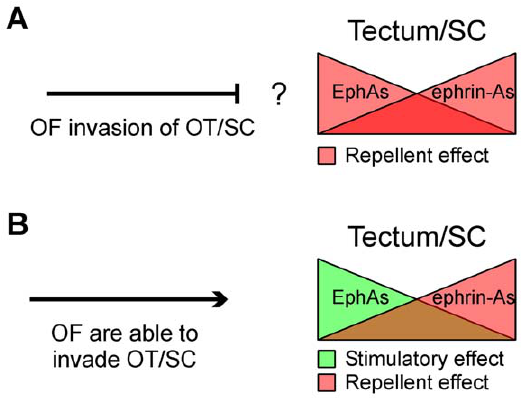
Figure 8. General models to account for topographic mapping along the rostro-caudal axis of the retinotectal/collicular system. In both models (A and B) opposing gradients of ephrin-As and EphAs establish the local addresses in the tectum/colliculus whereas opposing gradients of ephrin-As and EphAs establish the relative sensitivity of axons according to the RGC bodies location. Tectal/collicular ephrin-As inhibit temporal RGCs axon growth and termination zone formation. (A) In this model collicular EphA7 or EphA8 repel nasal RGC axon growth and inhibit termination zone formation. Repellent effect of EphAs on axon growth would prevent RGC axons from invading the colliculus. (B) In our model tectal EphA3 stimulates nasal RGCs axon growth and inhibits termination zone formation. This allows us to explain how RGC axons invade the tectum. Optic fibers (OF), Optic tectum (OT), superior colliculus